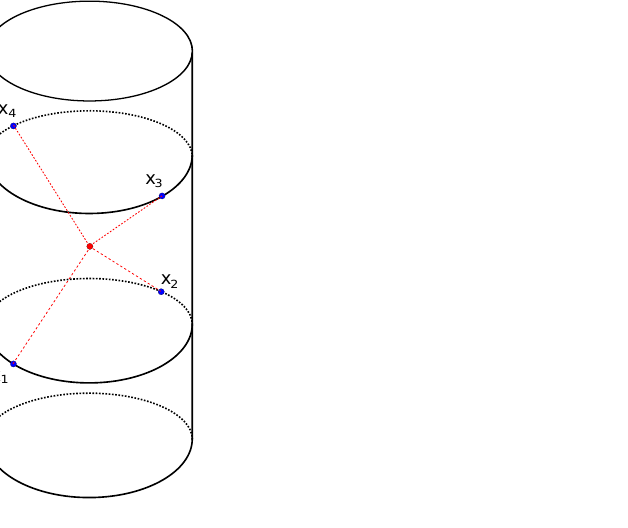
Figure 3 . Four CFT insertions that are not lightlike separated in the CFT, but whose bulk lightcones intersect at a